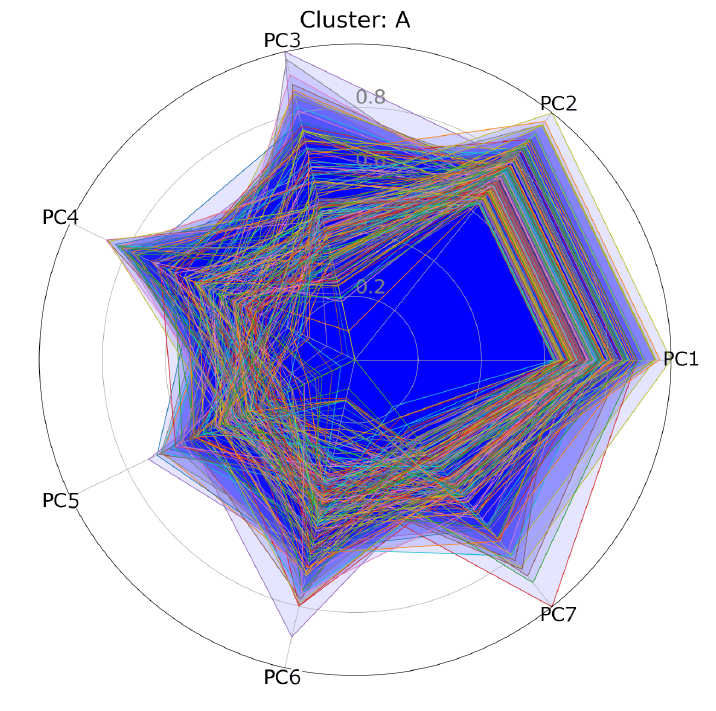
Figure 7. Stacked radar graphics showing cluster A of normalized values for case 2.